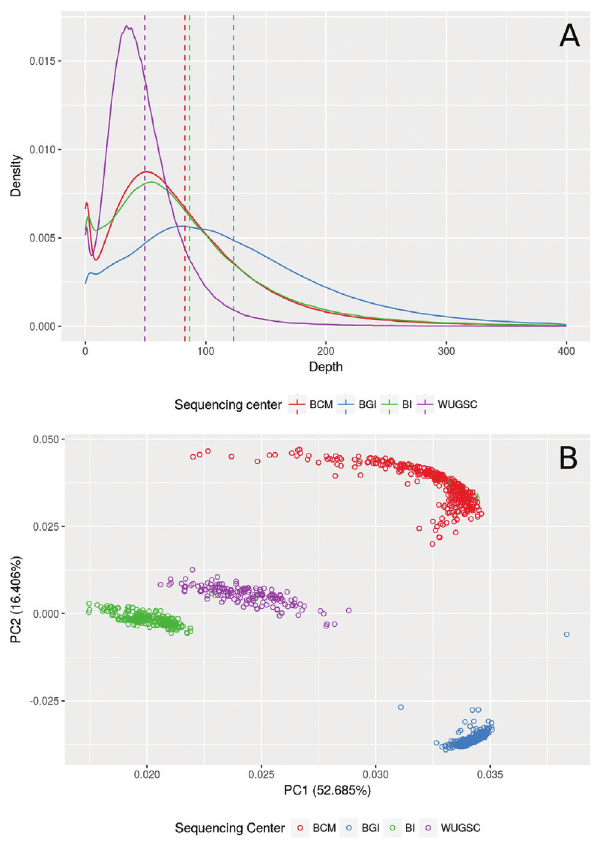
Figure 1 - Variation in depth of sequencing in different sequencing centers. Depth distribution varies significantly ( p < 0.001) among samples from the four sequencing centers included in this study (BCM - Baylor College of Medicine, BI - Broad Institute, BGI, and WUGC - Washington University Genome Center). (A) Density distributions for regions from ClinVar with depth from 0 to 400, with an average of 82.8 (cid:2) 67.6 for BCM, 123.0 (cid:2) 85.6 forBGI,86.6 (cid:2) 79.2forBI,and49.4 (cid:2) 33.8forWUGSC.(B)Principalcom- ponent analysis (PCA) corroborates our findings, with an explained vari- ance of 69.0% for the first two components. Complete depth distribution and an interactive 3D version of Figure 1B is available as File